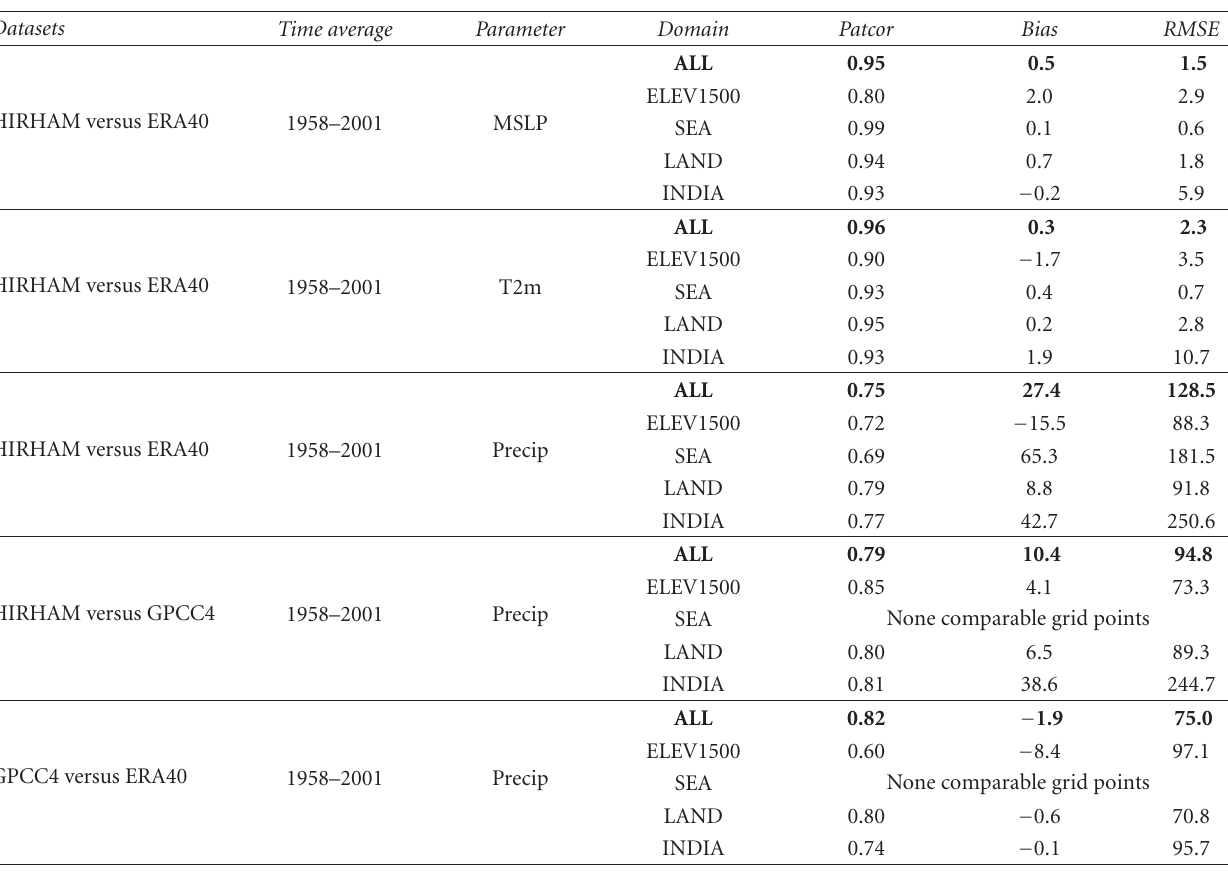
Table 2: Statistical parameters for HIRHAM model and observed data sets for mean sea level pressure (MSLP), 2m air temperature (T2m), and precipitation (Precip) in the entire model domain (ALL) and selected subdomains: mountain area > 1500m a.s.l. (ELEV1500), ocean (SEA), land surface (LAND) and Indian continent (INDIA), defined as pattern correlation coe ffi cient (PATCOR), di ff erence “HIRHAM model minus observation”, or the di ff erence between two observational data sets (BIAS) and root mean square error (RMSE) inhPa (MSLP), K (T2m) and mm (Precip).